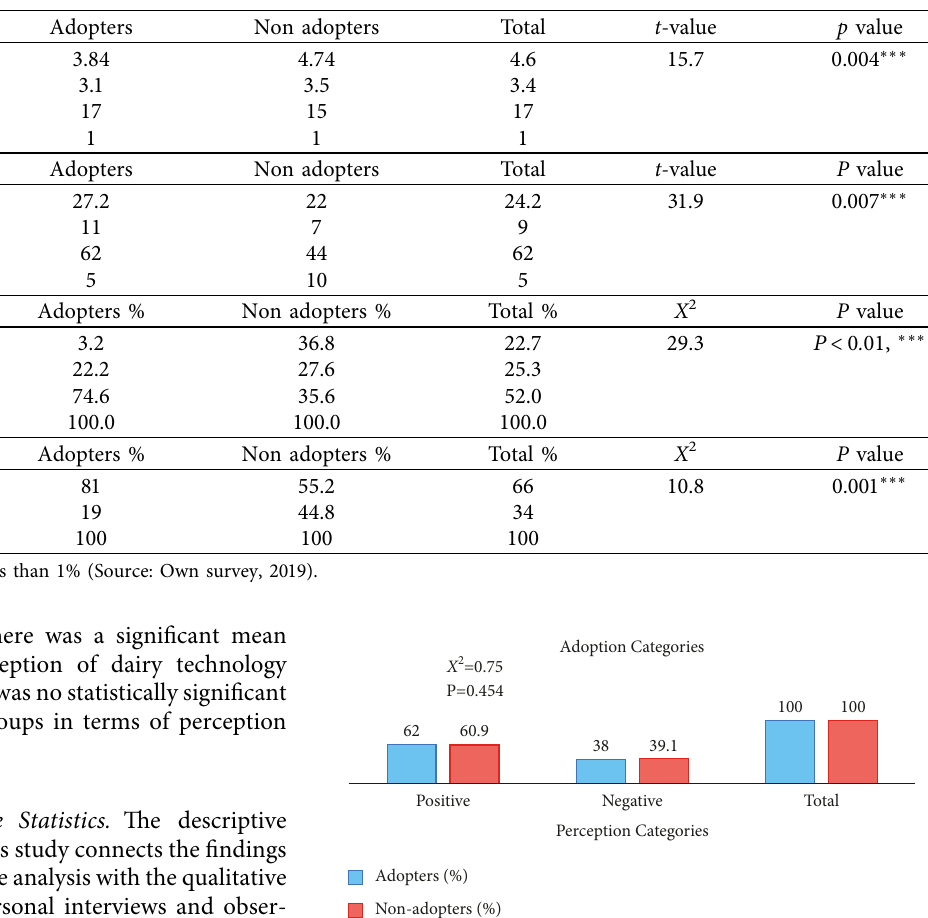
Table 5: Institutional